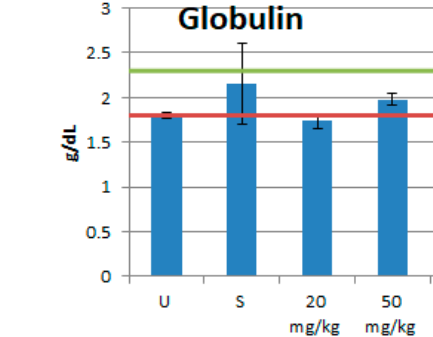
Figure 2. In vivo toxicity assessment of the compound 18 . Two doses (20 and 50 mg / kg) were administered intraperitoneally (IP) in CD-1 mice (n = 5 for each dose). Blood samples were collected 24 h later and tested by 14 parameters for organ functions. The red and green lines indicate the normal ranges for the assays. U, untreated animals; S, animals injected with saline (vehicle